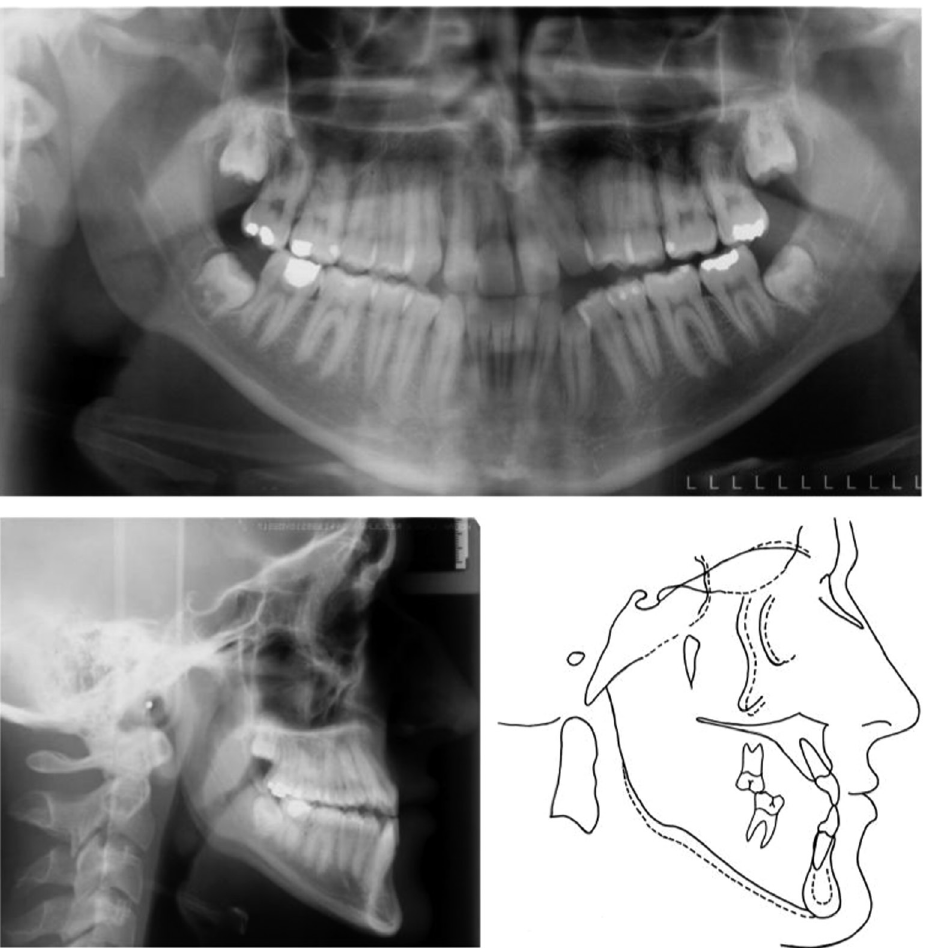
Figure 2. Pretreatment